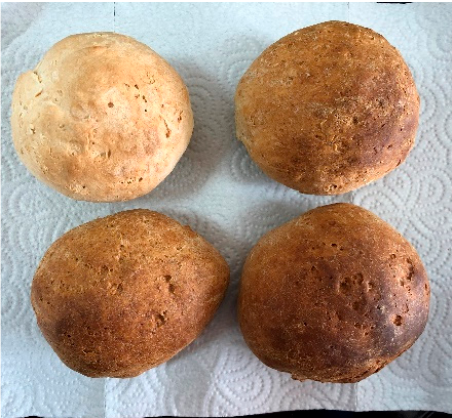
Figure 1. Baked breads enriched with chufa flour